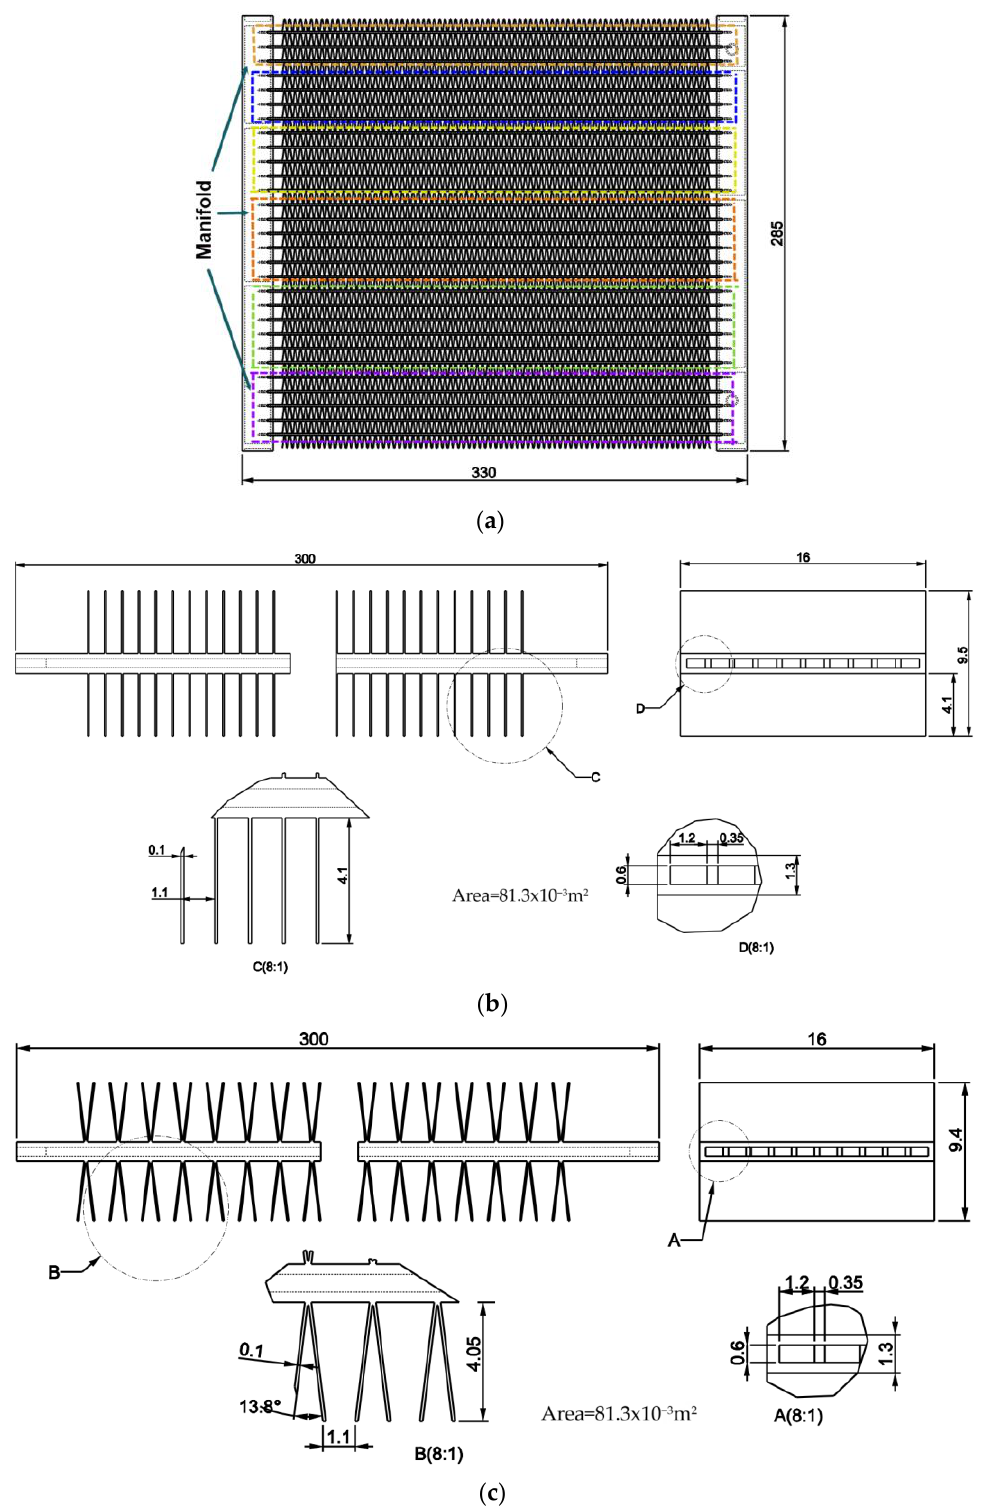
Figure 1. Dimensions of the microchannel evaporator: ( a ) Front view; ( b ) A flat tube drawing with the straight fins; ( c ) A flat tube drawing with the V-fins. Table 1. Detailed geometries of the microchannel evaporator with the straight fins and the V-fins.